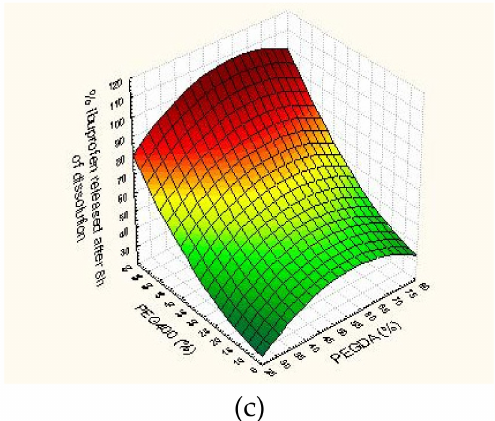
Figure 4. Interaction e ff ect of excipients on ibuprofen released after 8 h of dissolution. ( a ) x- polyethylene glycol (PEG) 400 (%), y—water (%), ( b ) x—polyethylene glycol diacrylate (PEGDA) (%), y—water (%), ( c ) x—PEG 400 (%), y—PEGDA (%), z axis on all graphics—cumulative % of ibuprofen released after 8 h of dissolution test.